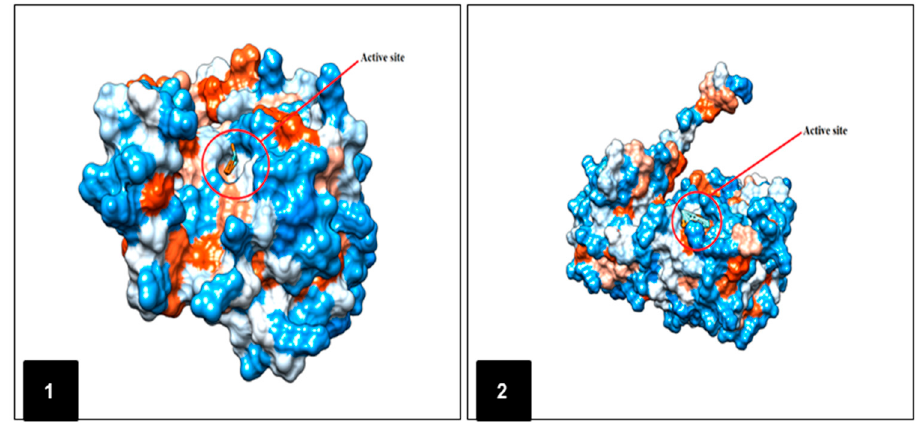
Figure 2. Structure two proteins modeling and their active sites by Chimera molecular graphic software; ( 1 ) ALT (Alanine aminotransferase) model and ( 2 ) AST (Aspartate aminotransferase) model. The best protein-based model stabilized, least energy and low RMSD (Root Mean Square Deviation) was obtained with Nano Molecular Dynamics (NAMD) and the graph [50]. The best model was selected on the basis of model evaluation tools, ProSA-web Z-scores and RAMPAGE Ramachandran plots [51] (Figure